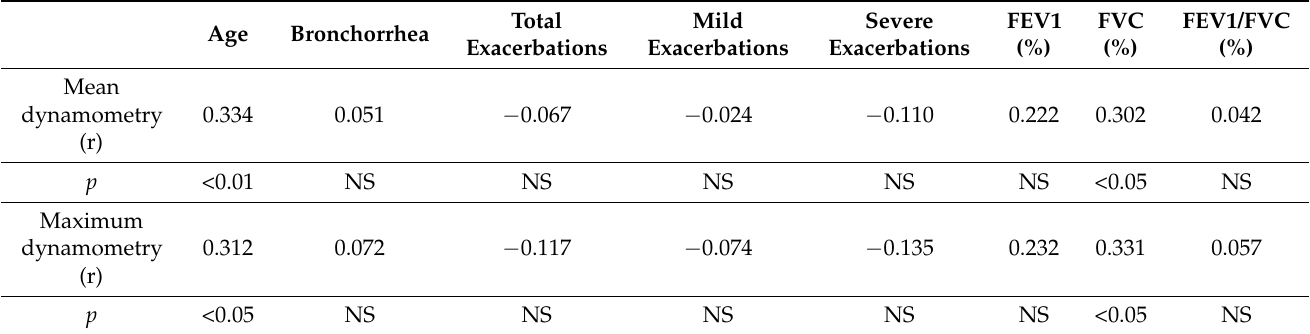
Table 2. Correlations between muscle strength and respiratory